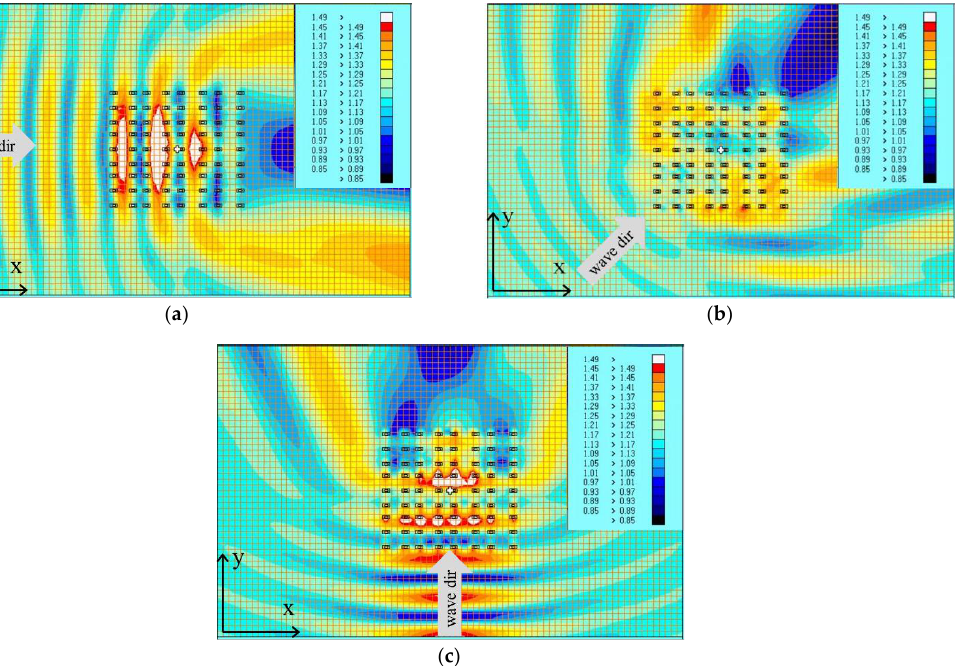
Figure 4. Wave elevation contour: ( a ) incident angle = 0°; ( b ) incident angle = 45°; ( c ) incident angle = 90°.